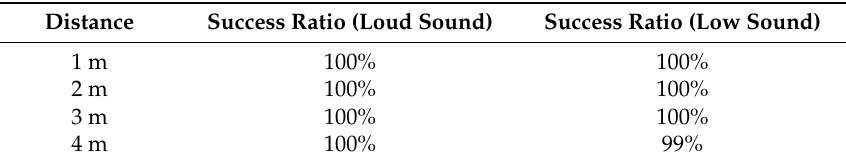
Table 4. Successful perception rate of the voice without considering the distance.